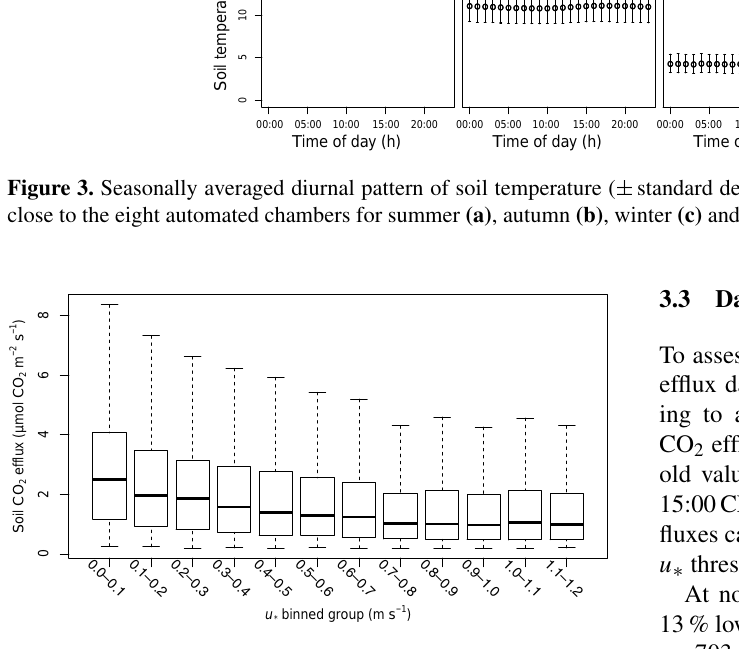
Figure 4. Box plot of mean hourly soil CO 2 effluxes for the 1-year campaign plotted against the binned groups of friction velocity ( u ∗ )